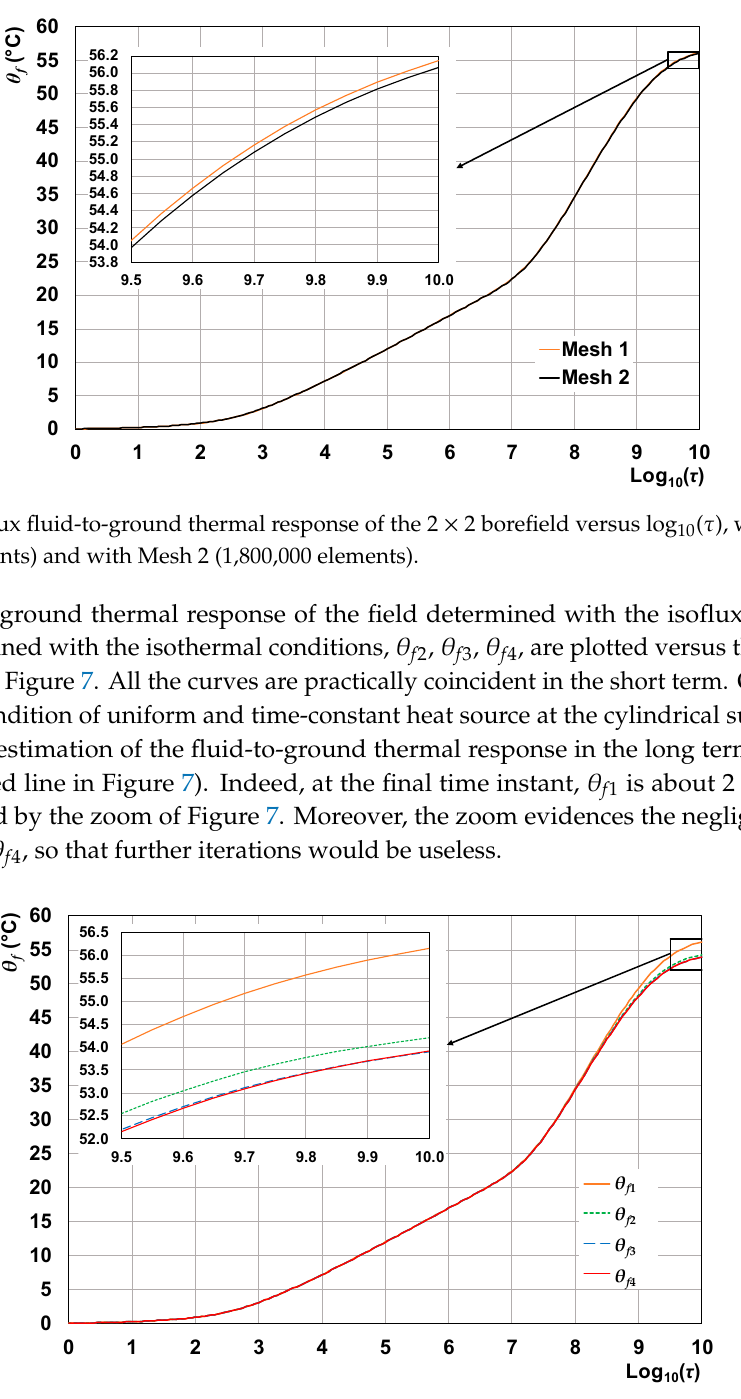
Figure 5. Computational domain, with mesh, for the 2 × 2 borefield.